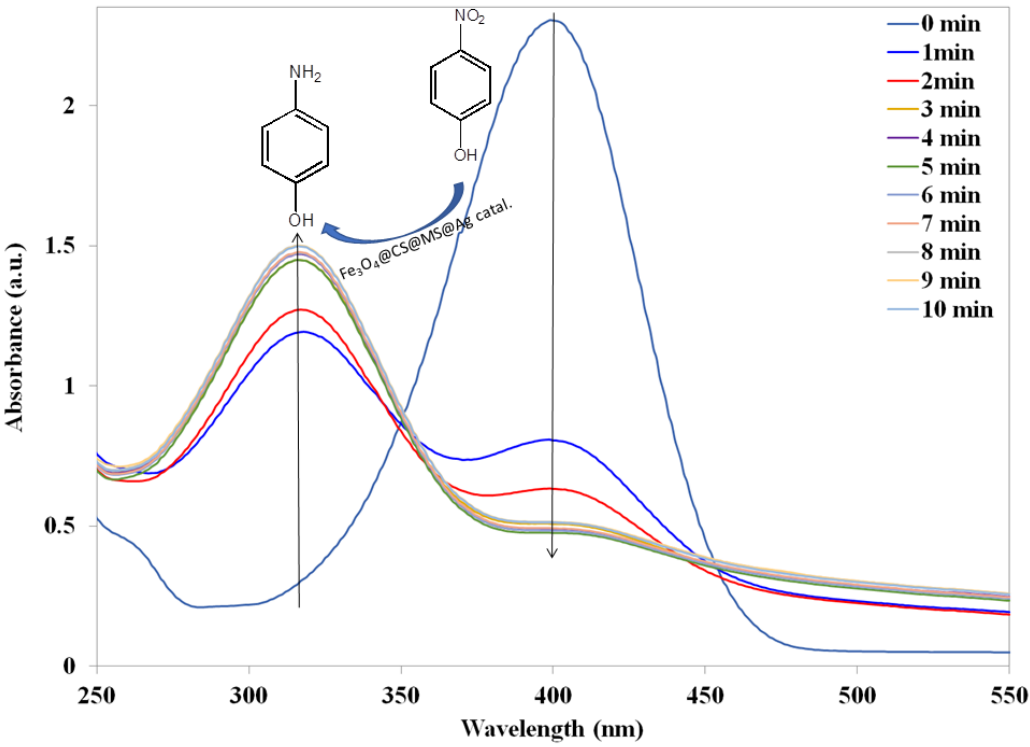
Figure 10. Monitoring the progress for the reduction of 4-NP to 4-AP using 0.8 mg (6.5 × 10 − 7 mol Ag) of Fe 3 O 4 @CS@MS@Ag as catalyst.